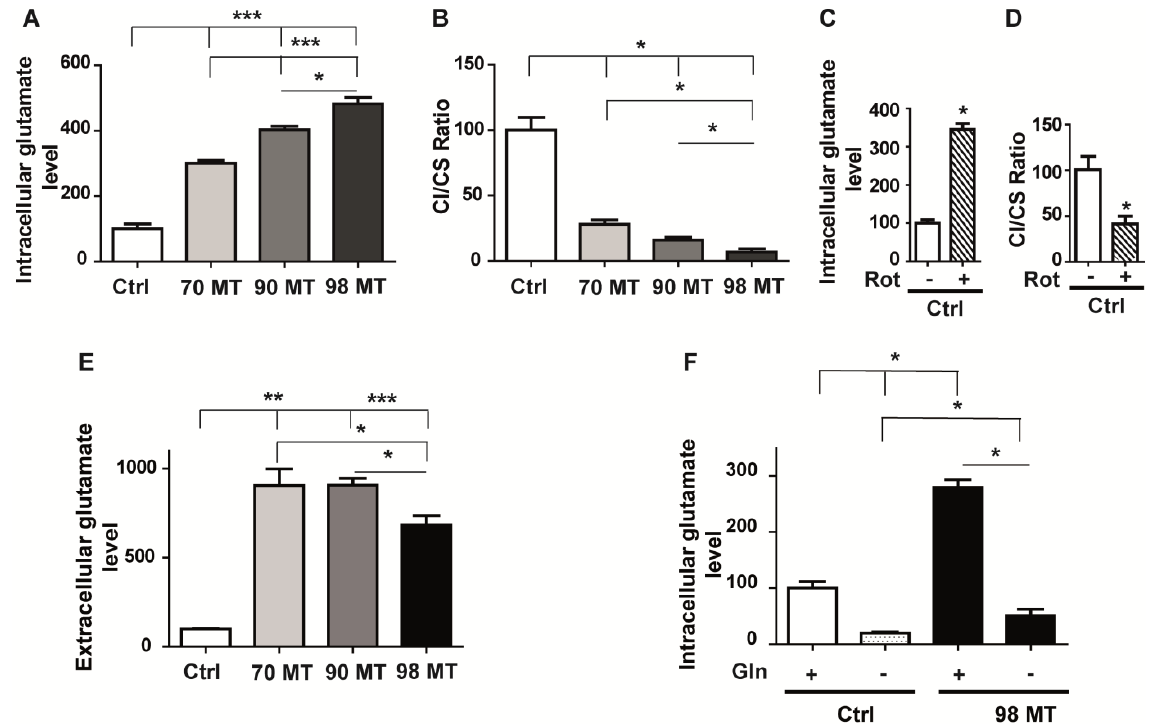
Figure 2. Glutamate concentration is correlated with complex I deficiency in MELAS cells. ( A ) In- tracellular levels of glutamate in control (Ctrl) and mutant (MT) cells (70%, 90%, and 98%). ( B ) Bio- chemical assessment of mitochondrial complex I activity in Ctrl and MT cells (70%, 90%, and 98%). ( C ) Intracellular level of glutamate in Ctrl cells treated for 15 h with rotenone (200 nM) or a vehicle. ( D ) Biochemical assessment of mitochondrial complex I activity in Ctrl cells treated for 15 h with rotenone or a vehicle. ( E ) Extracellular glutamate levels. Ctrl: control cells and MT cells carrying different mutation loads (70%, 90%, and 98%). ( F ) Intracellular glutamate levels in Ctrl and 98% MT cells with (+) or without ( − ) the addition of glutamine. Results are presented as the mean ± SEM relative to Ctrl cells of at least 4 independent experiments. Statistical differences between MT and Ctrl cells are indicated with an asterisk (* p < 0.05; ** p < 0.01; *** p <